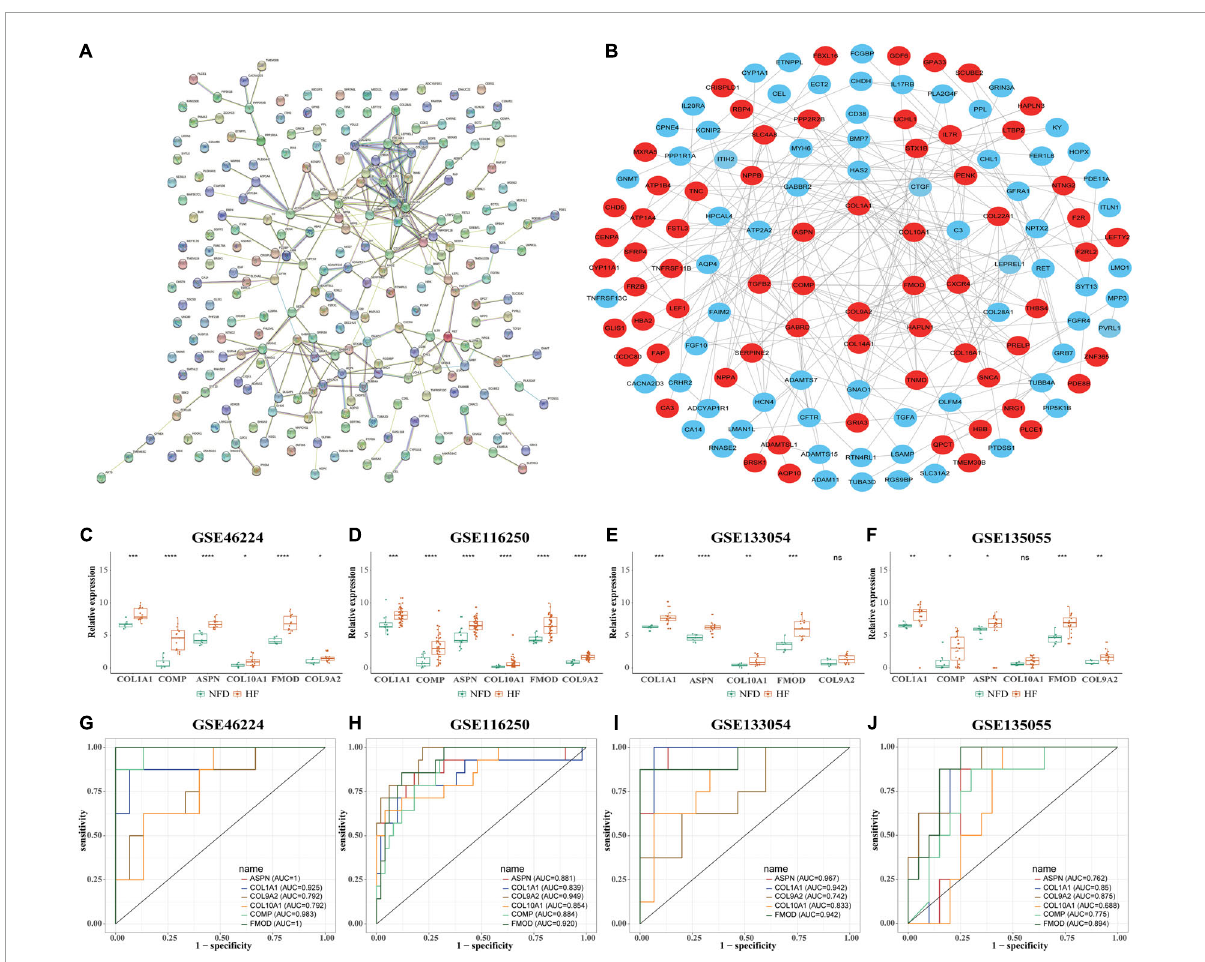
FIGURE7 Identification of HF-related hub genes from the four selected RNA-seq datasets. (A) PPI network of the 201 DEGs in patients with HF was constructed by using the STRING database. The nodes represent proteins, and the edges represent the interactions. (B) Robust hub genes were screened by degree using the cytoHubba plug-in in Cytoscape. The inner the concentric circles, the larger the degree values of the genes. (C–F) Relative expression of the six identified hub genes in GSE46224 (C) , GSE116250 (D) , GSE133054 (E) , and GSE135055 (F) , respectively. ns, not significant vs. the NFD group; * p < 0.05 vs. the NFD group; ** p < 0.01 vs. the NFD group; *** p < 0.001 vs. the NFD group; **** p < 0.0001 vs. the NFD group. (G–J) Diagnostic values of the six identified hub genes in GSE46224 (G) , GSE116250 (H) , GSE133054 (I) , and GSE135055 (J) , respectively, as determined by ROC curves. HF, heart failure; RNA-seq, RNA sequencing; PPI, protein–protein interaction; DEGs, differentially expressed genes; STRING, search tool for the retrieval of interacting genes; NFD, non-failing donor; ROC, receiver operating